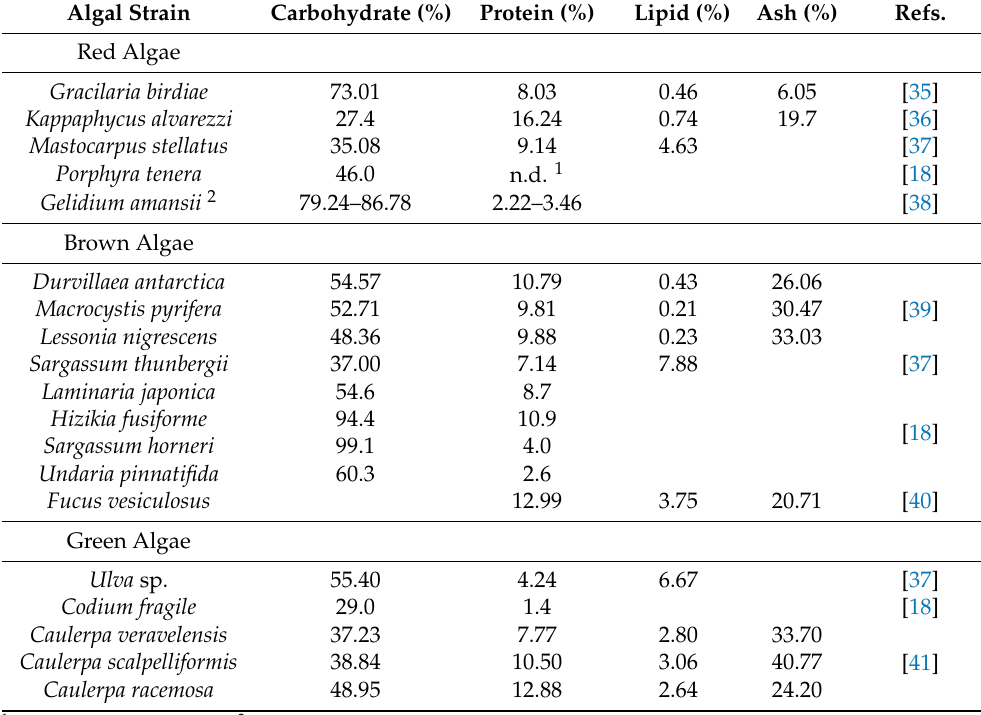
Table 1. Chemical composition of various macroalgae containing sulfated polysaccharides. Algal